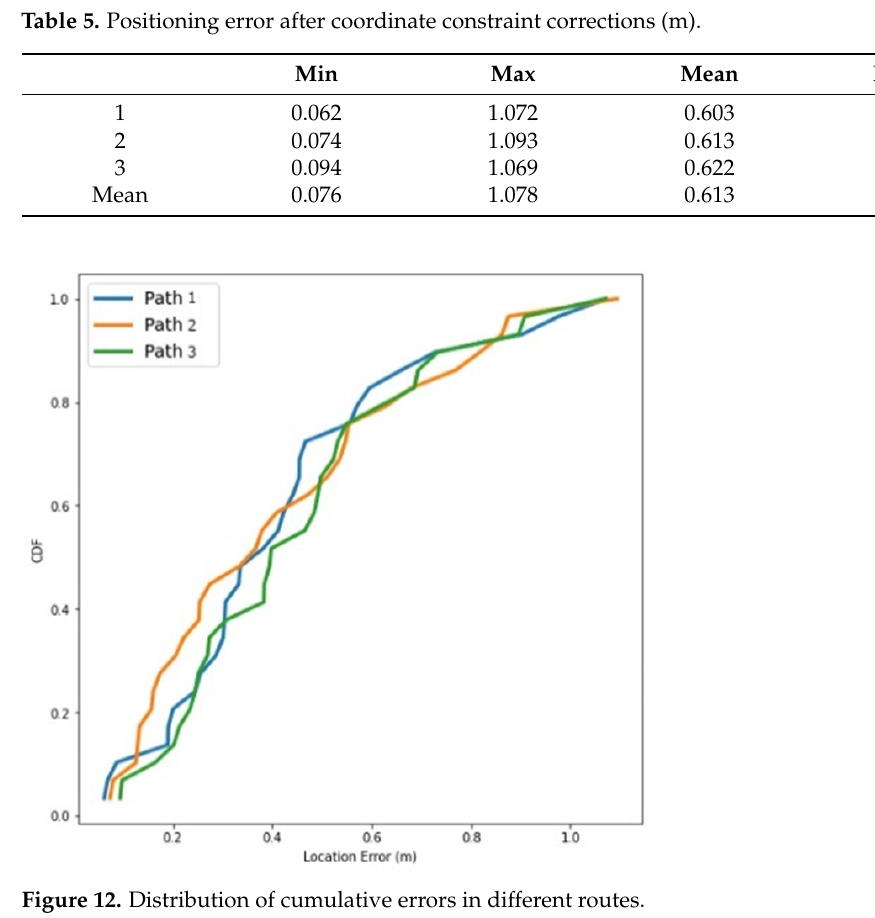
Table 5. Positioning error after coordinate constraint corrections (m).